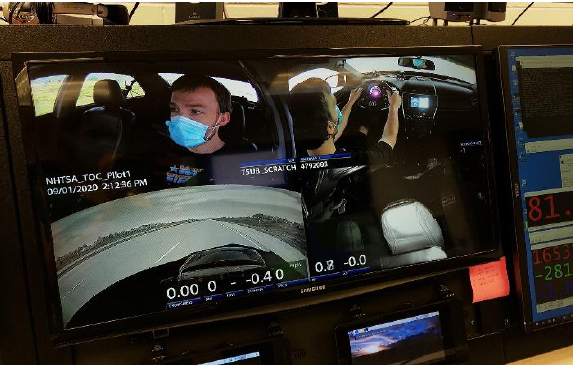
Figure 2 . National Advanced Driving Simulator (NADS). Each reader had to make a yellow light judgment six times during the trial, which required each participant to complete the task 18 times. Additionally, secondary activities were conducted at random and exposed participants to three different cell phone interfaces: baseline (no phone call), outgoing call (calling out), and incoming call (answering a call). Before entering each sector, calls started coming in and going out. There are 1157 rows of data in the original dataset, which was compiled from 49 people. One yellow event's data is represented by one row. For every drive or visit, each participant should have a maximum of six